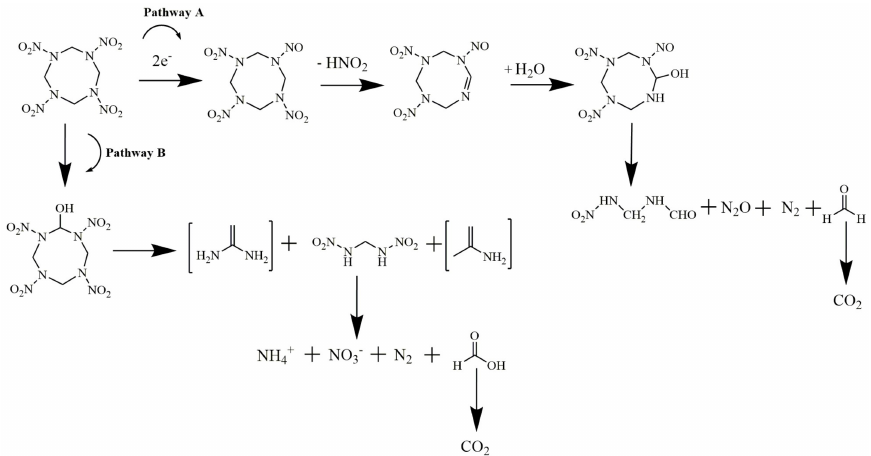
Figure 2. Possible pathways for the electrochemical degradation of HMX. Square brackets indicate undetected